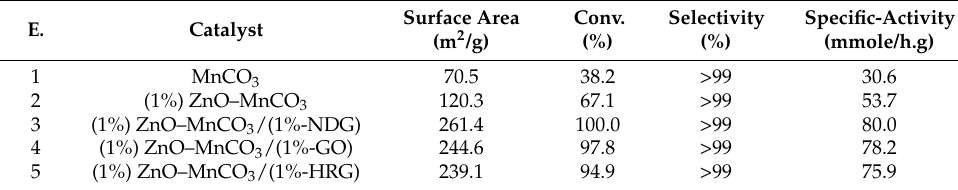
Table 1. Catalytic dehydrogenation of BOH using different prepared catalysts.